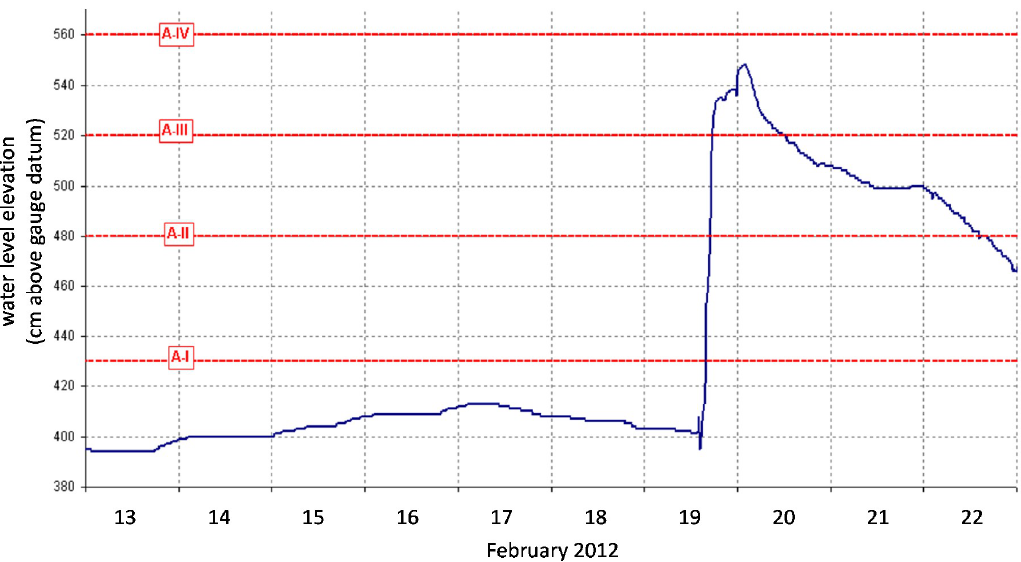
Figure 8. Abrupt rise in water levels at Ratzdorf (Oder-km 542) in February 2012. Water levels almost reached Level A-IV of the flood warning system, which would have left a short response for additional protective measures ( source: Wasser- und Schifffahrtsverwaltung, Eberswalde, Germany).